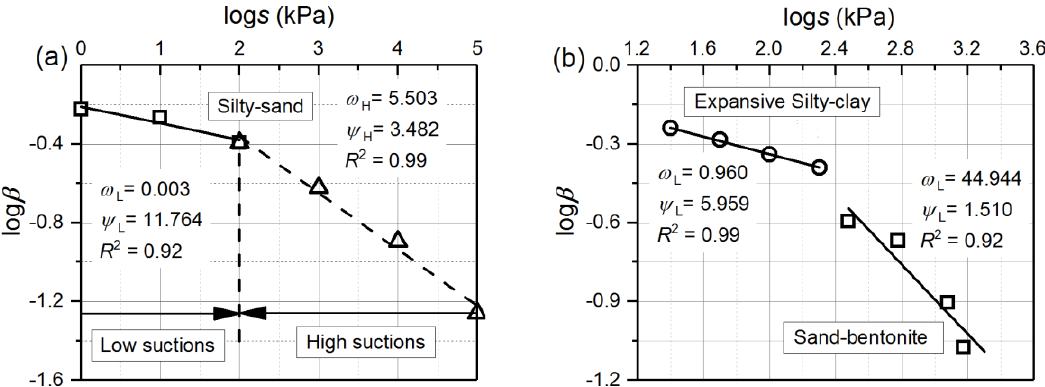
Figure 10. Linear relationship between in the log s –log e plane at constant suction with data from Table 3: ( a ) at full suction range; ( b ) at low suctions.